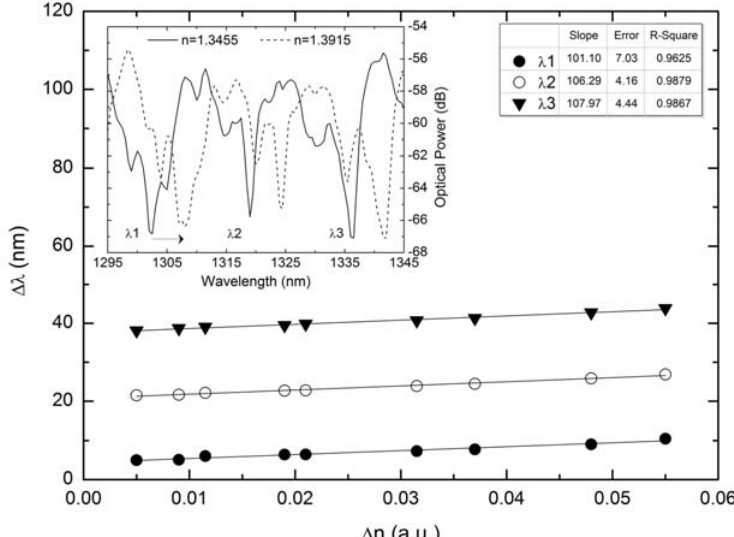
Figure 10. Wavelength shift of different peak as a function of the surrounding refractive index. Inset: Typical spectral output of the silica tube